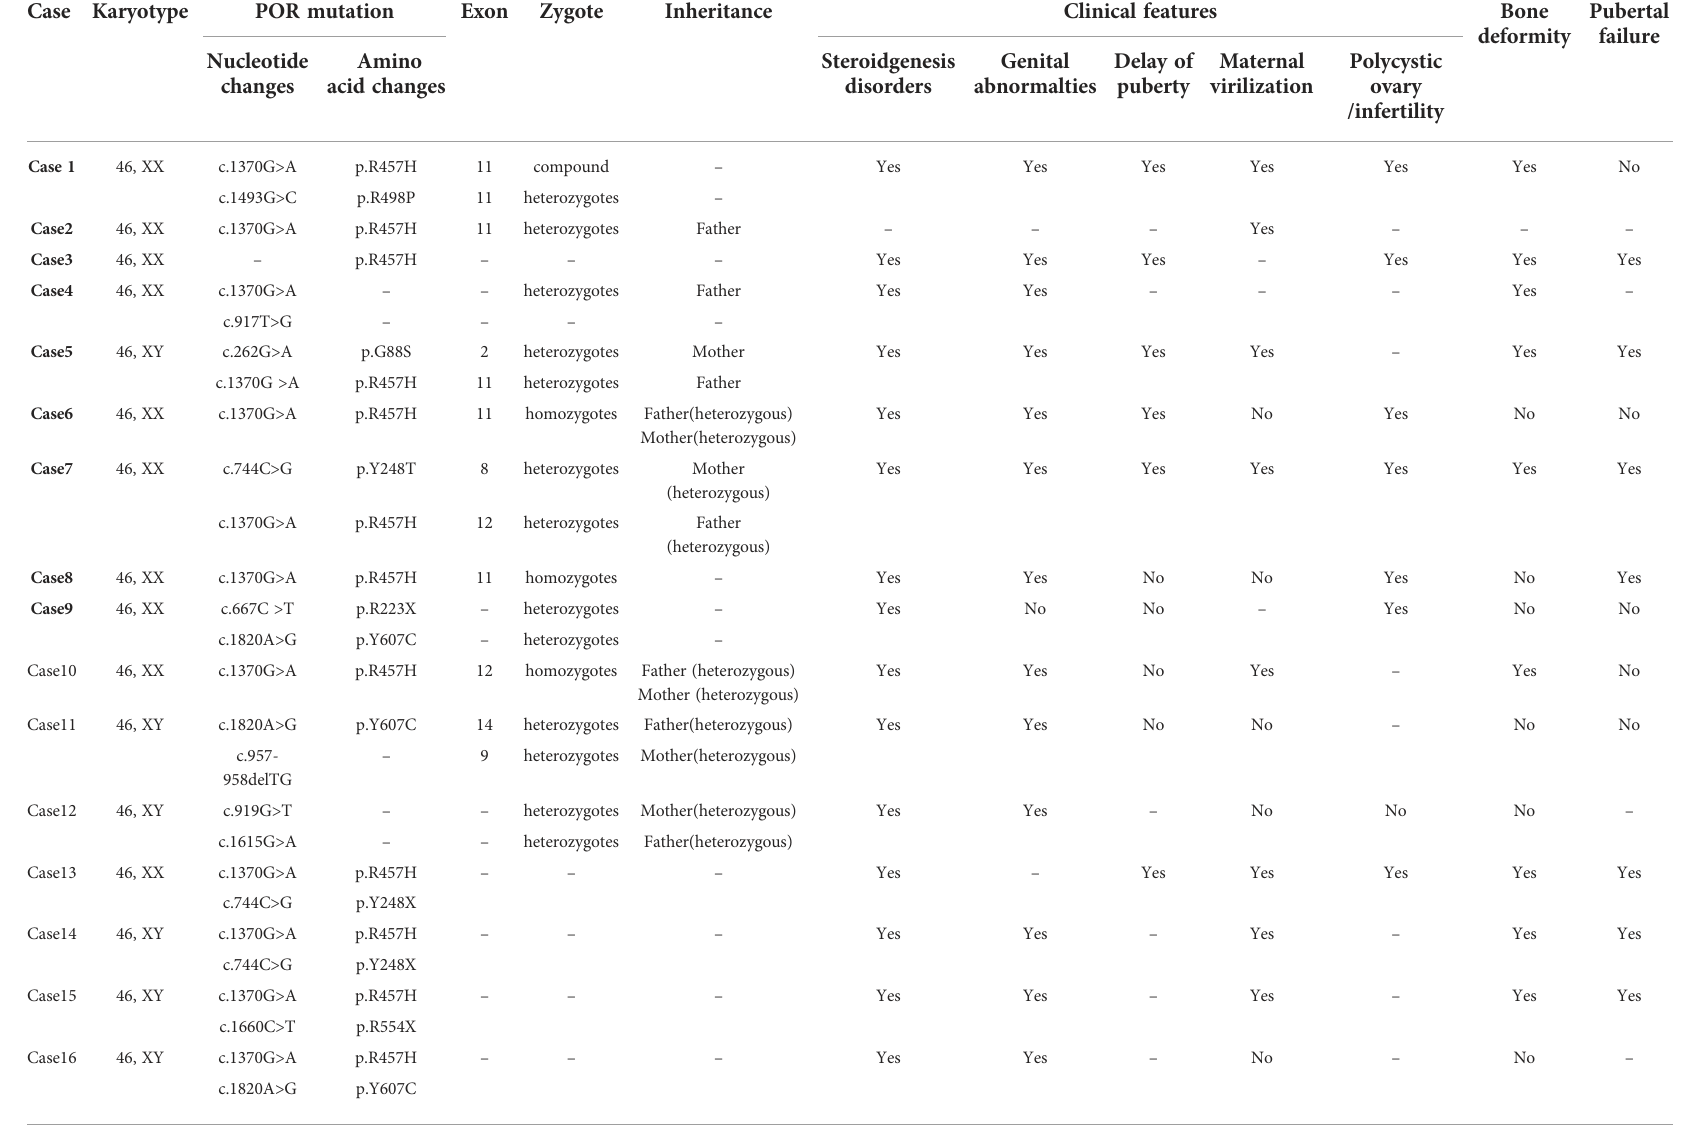
TABLE 3 Summary of gene results and clinical characteristics of 20 Chinese patients with